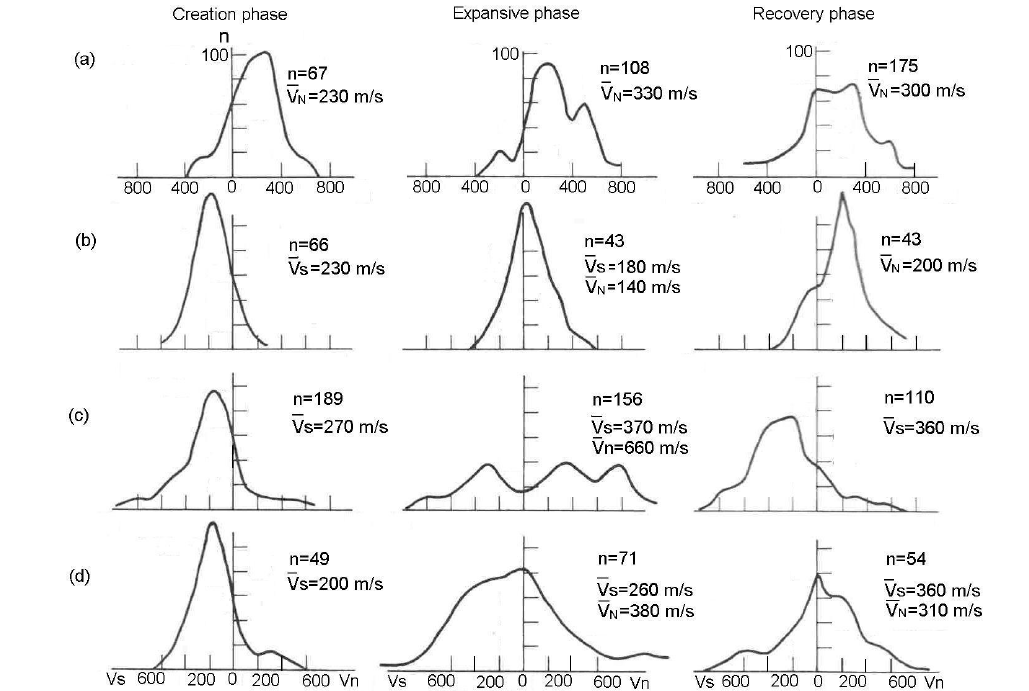
Figure 25. Distribution of meridional velocities of individual auroral forms in the daytime (a) , evening (b) , midnight (c) , and morning sectors (d) of the auroral oval for different substorm phases (Vorobjev et al., 1976b). V S and V N represent the mean values of southward and northward arc velocities, respectively, and n is the number of